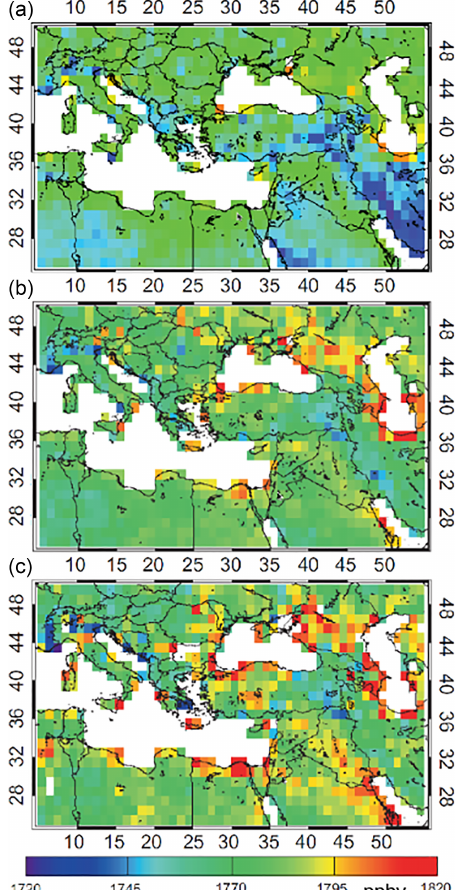
Figure 22. Maps by 1 ◦ × 1 ◦ resolution of dry air column-averaged mole fractions, denoted as SCIAMACHY WFM-DOAS XCH 4 lev- els, in 2003, including a yearly average (a) , a summer average (b) , and an August average (c) in ppbv (from Georgoulias et al., 2011; used with permission from Taylor and Francis).